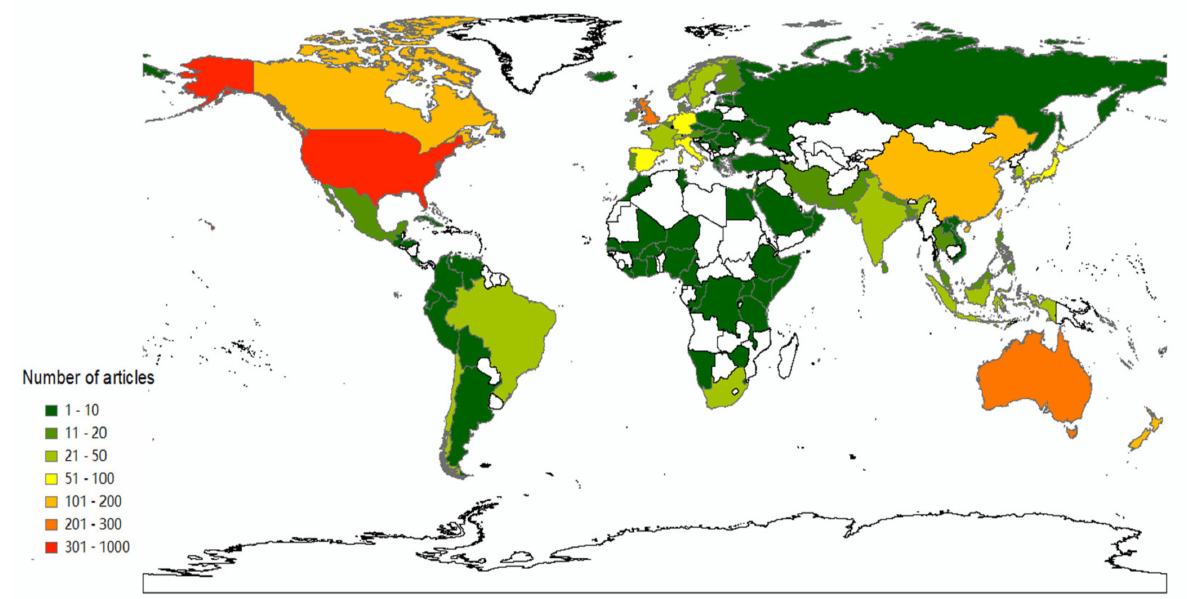
Figure 3. Geographical distribution of publications in the community resilience research from 2001 to 2020. The map was created by ArcGIS 10.2 software. Red areas indicate the most publications and dark green areas indicate the fewest publications. Blank areas mean that no relevant literature data has been